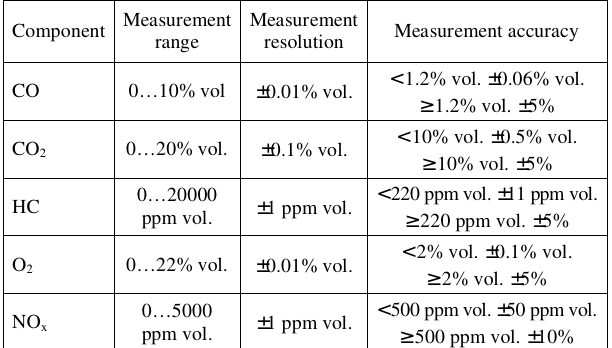
Table 2. Parameters of the exhaust gas analyser